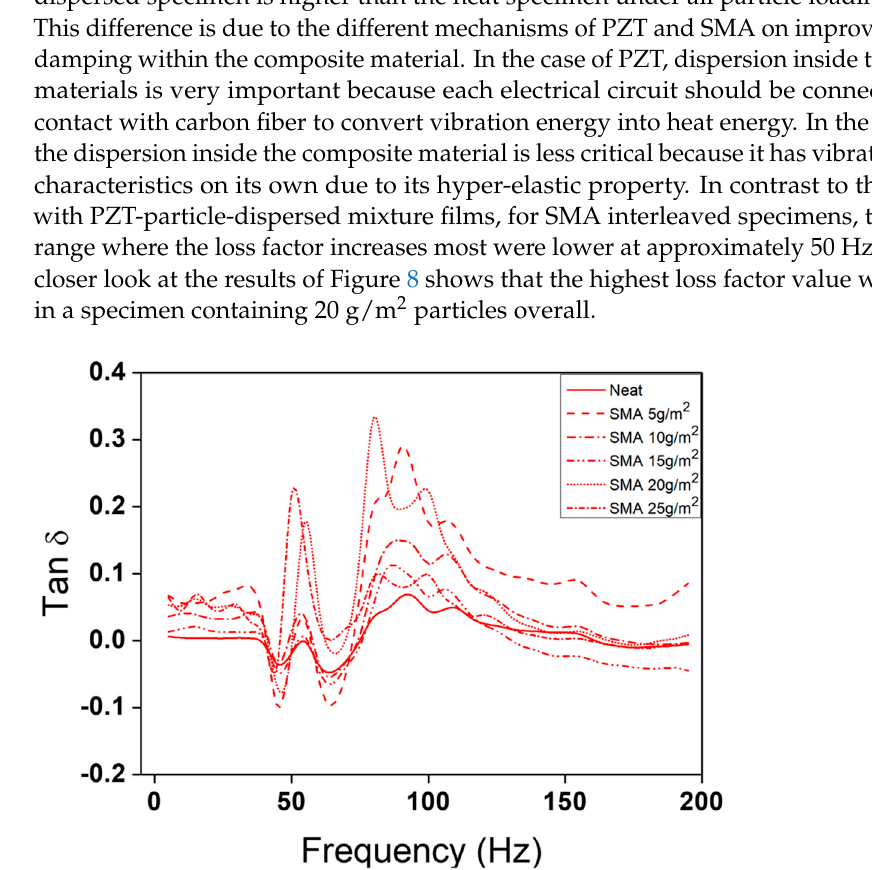
Figure 8. Loss factors (tan δ ) of CFRP specimens with SMA-particle-dispersed mixture film as functions of the frequency. Measurement data for different particle loadings.